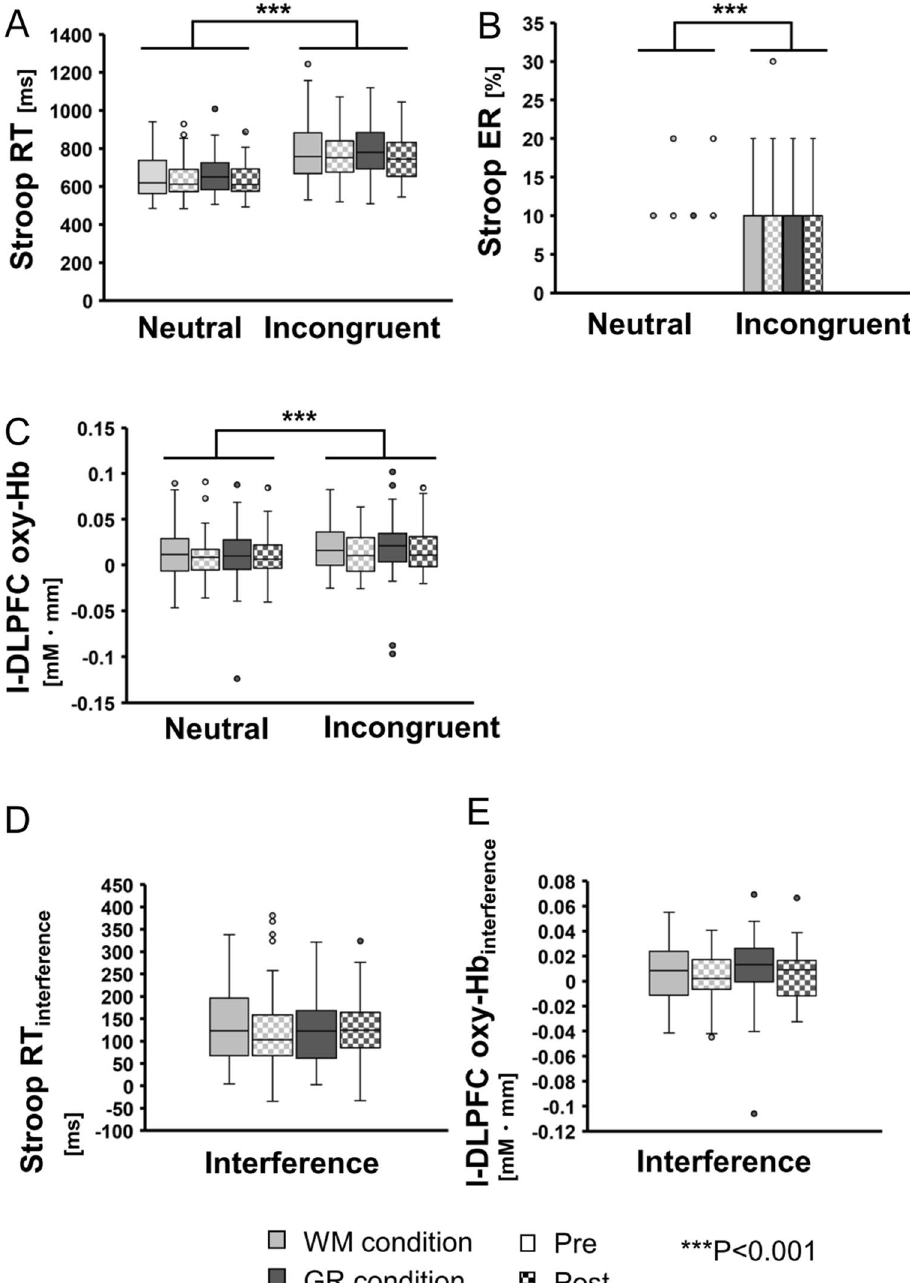
Figure 1. ( A ) Reaction time (RT) of neutral and incongruent conditions of the Stroop task. ( B ) Error rate (ER) of neutral and incongruent conditions of the Stroop task. ( C ) l-DLPFC oxy-Hb for neutral and incongruent conditions. Slower RT and higher ER in the incongruent condition exhibited significant Stroop interference effects. ( D ) Stroop interference against RT for the Stroop task. The repeated measures two-way ANOVA revealed no significant differences. ( E ) Stroop interference against l-DLPFC oxy-Hb. The repeated measures two-way ANOVA revealed no significant differences. Values are represented as box plots where the bottom, middle, and top lines of the boxes are the 25th, 50th (median), and 75th percentiles, respectively, and the whiskers above and below each box indicate the most extreme point within 1.5 times the interquartile range. The points above or below the whiskers represent outliers. *** P <